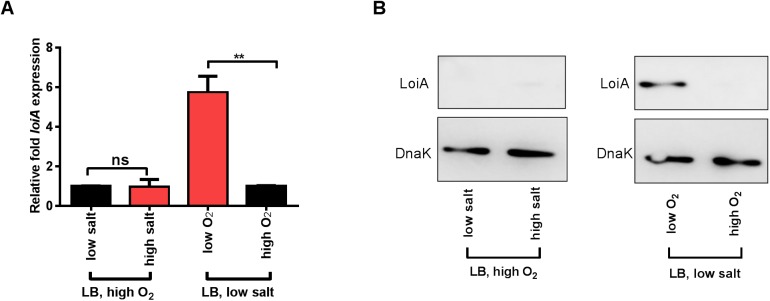
Expression of LoiA was induced by low O2 concentration.(A) qRT-PCR analysis of loiA gene expression under high O2 or low O2 (LB, low salt), and high salt (0.3M NaCl) or low salt (0.17M NaCl) conditions (LB, high O2). Data are representative of at least three independent experiments and are presented as mean ±SD. P values were determined by student’s t test (**P<0.01; ns, not significant). (B) Western blot analysis of LoiA protein level under high O2 or low O2 (LB, low salt), and high salt or low salt conditions (LB, high O2). The expression of the tagged LoiA protein was determined using that of DnaK as the internal control.